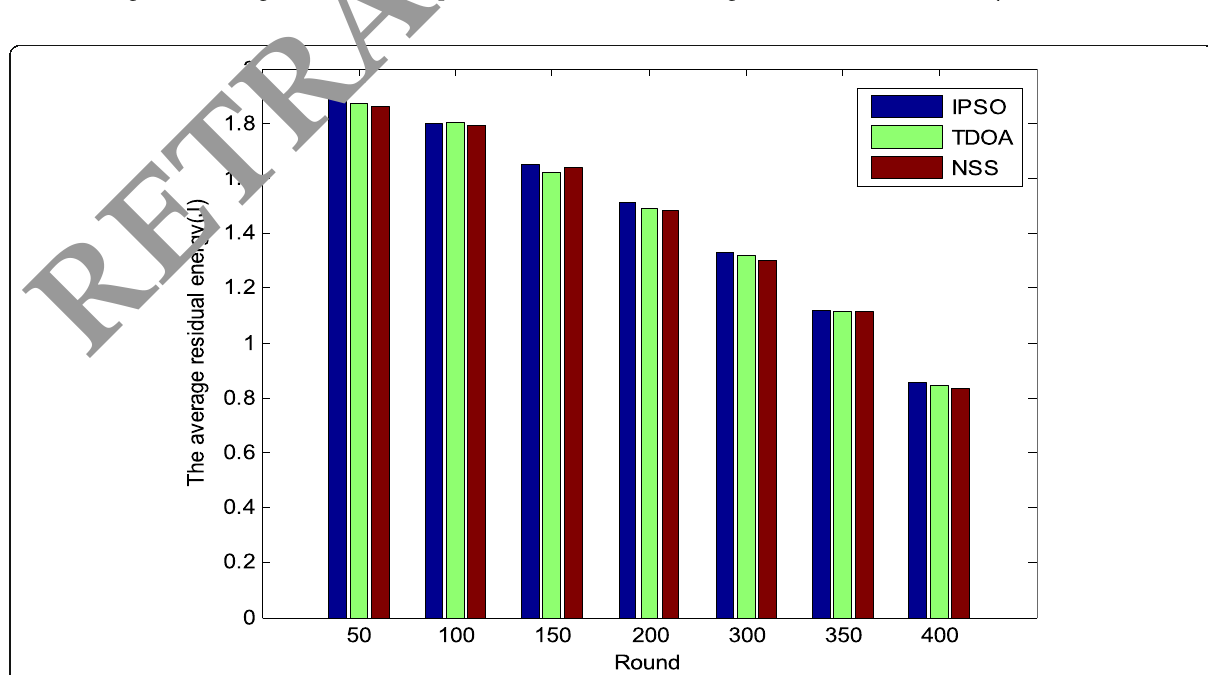
Fig. 8 Comparison of average residual energy of three